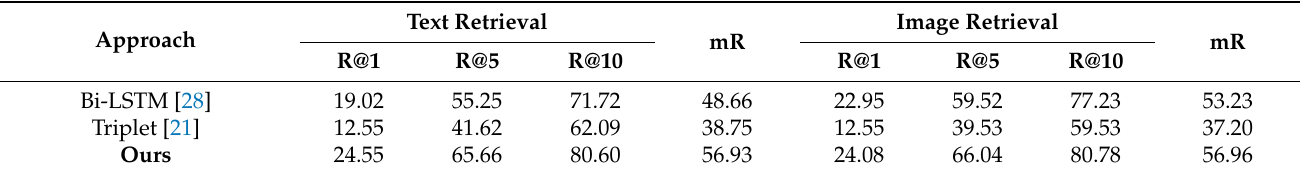
Table 5. Comparison between the state-of-the-art retrieval methods in the TextRS dataset in terms of R@K.